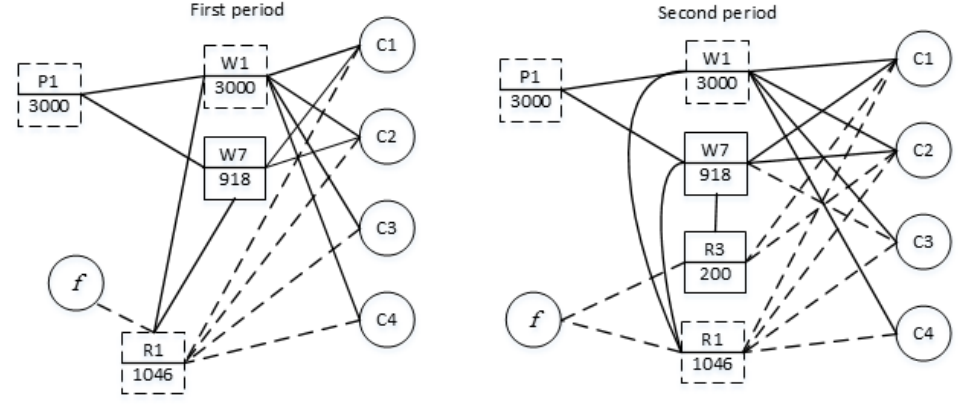
Fig. 3. Robust network structure for first and second periods.